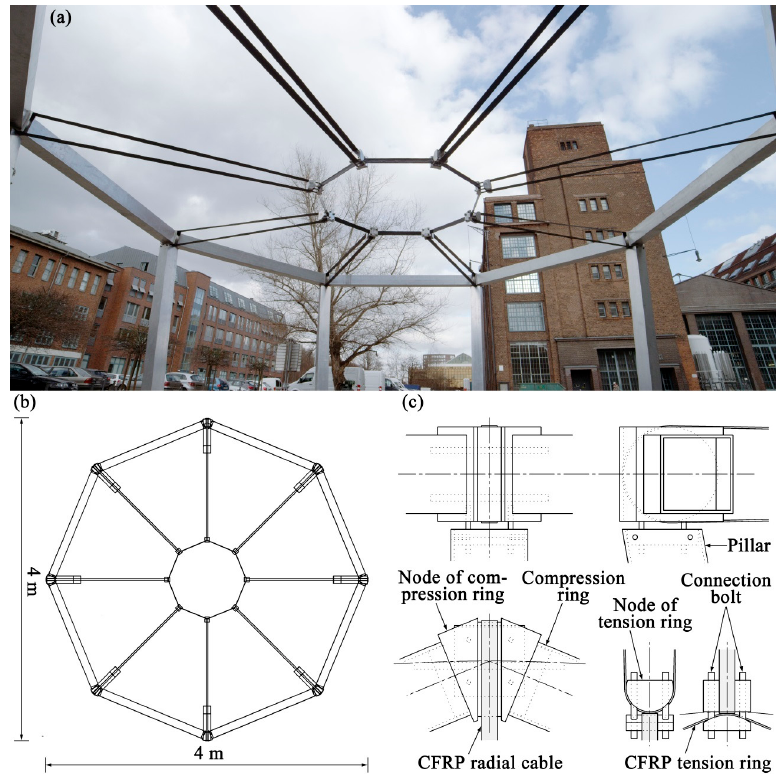
Figure 29. ( a ) Photo of CFRP spoked wheel cable roof at TU Berlin (photo credit: Till Beckmann); ( b ) plan view; and ( c ) nodes of compression ring and tension ring.